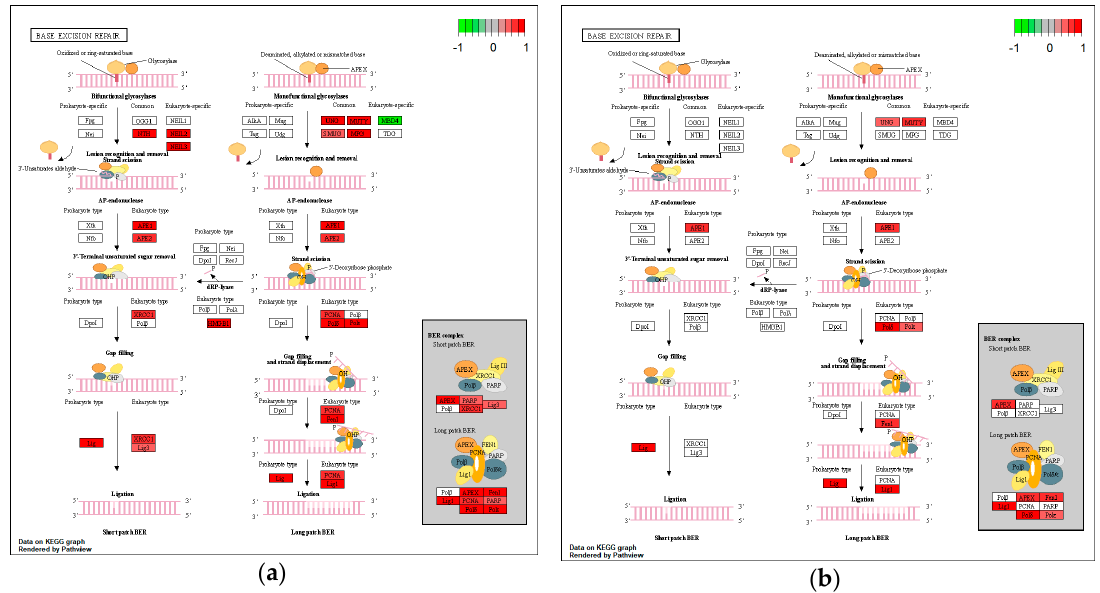
Figure 2. Impact of H. pylori infection ( a ) and CagA protein ( b ) on gene expression of base excision repair (BER) components, visualized in KEGG pathway map. Components involved in the process are highlighted in red (downregulated) or green (upregulated).